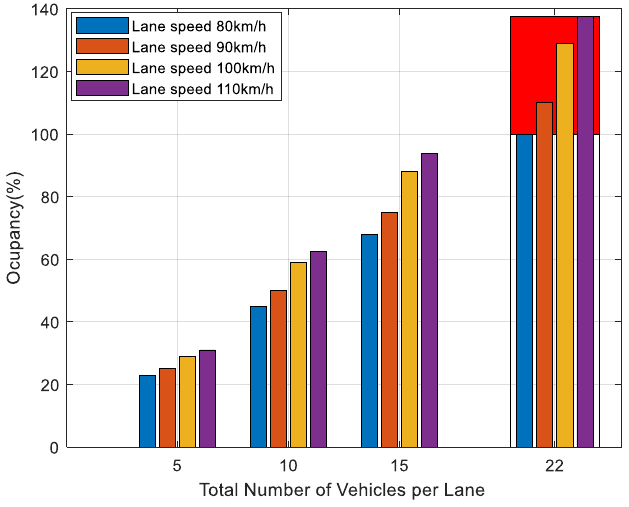
Figure 8. Percentage of lane occupancy.